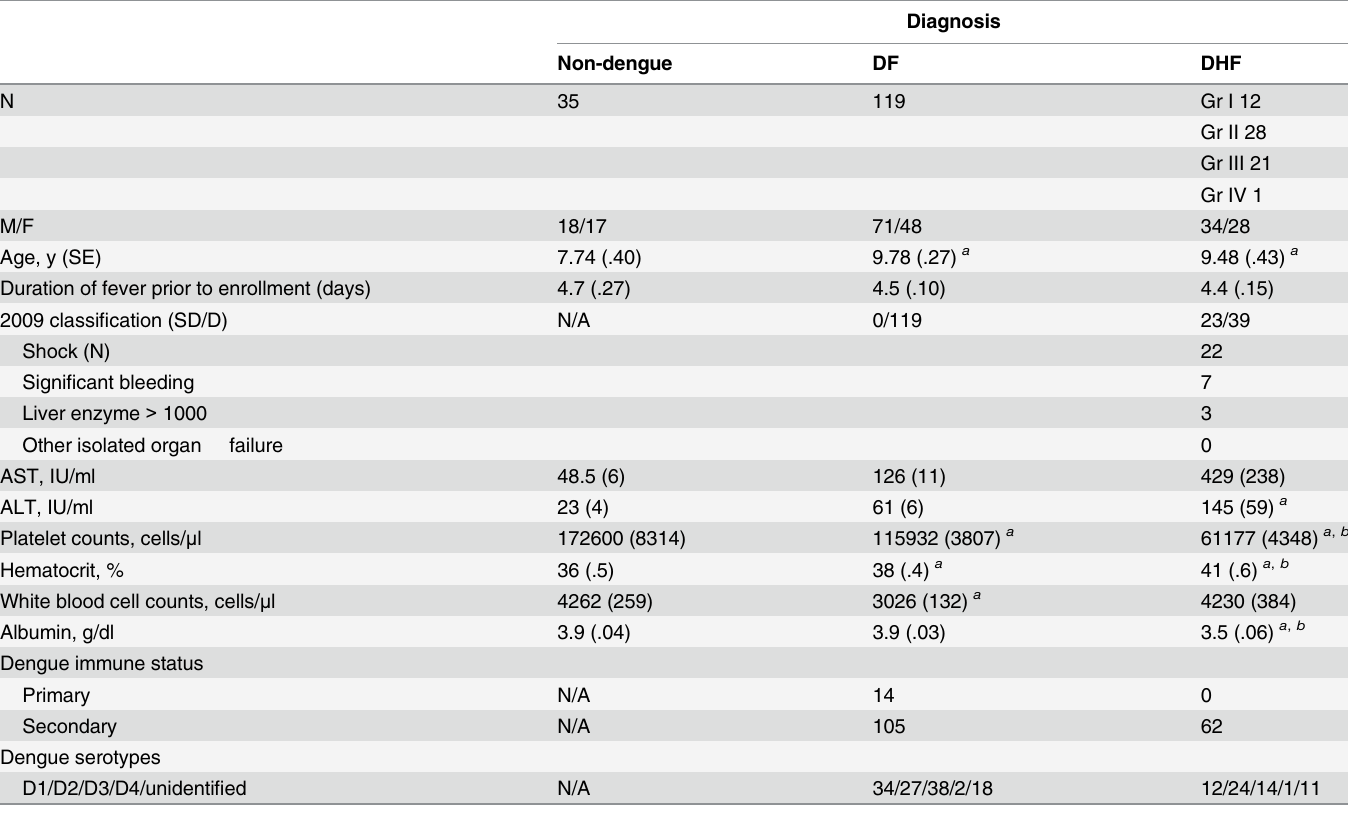
Table 1. Clinical characteristics of study